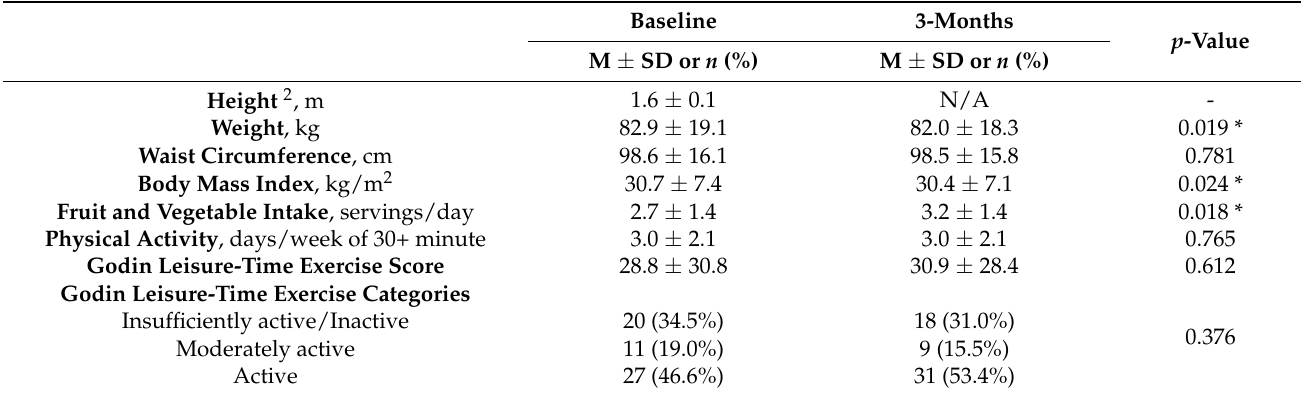
Table 2. Participant ( n = 76) 1 anthropometrics, fruit and vegetable intake and physical activity measures at baseline and after the 3-month team-based